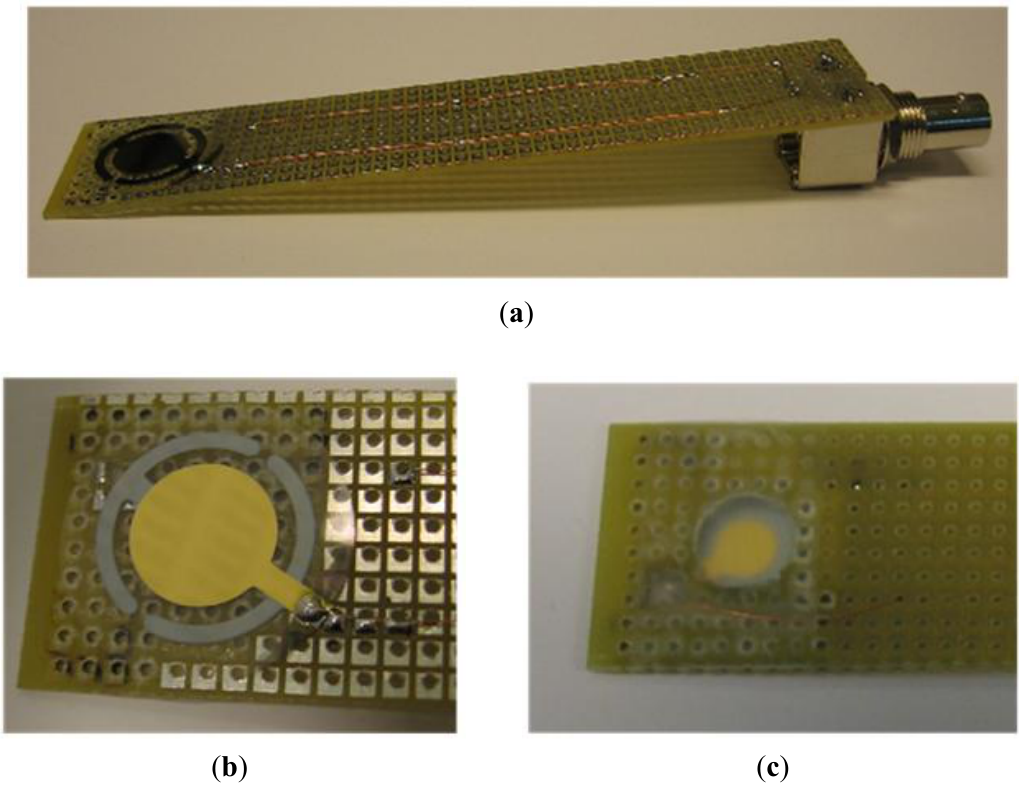
Figure 4. Quartz crystal holder designed for real-time battery measurements. ( a ) Appearance of the crystal assembled on the holder; ( b ) Detail of crystal area; ( c ) Air chamber for crystal